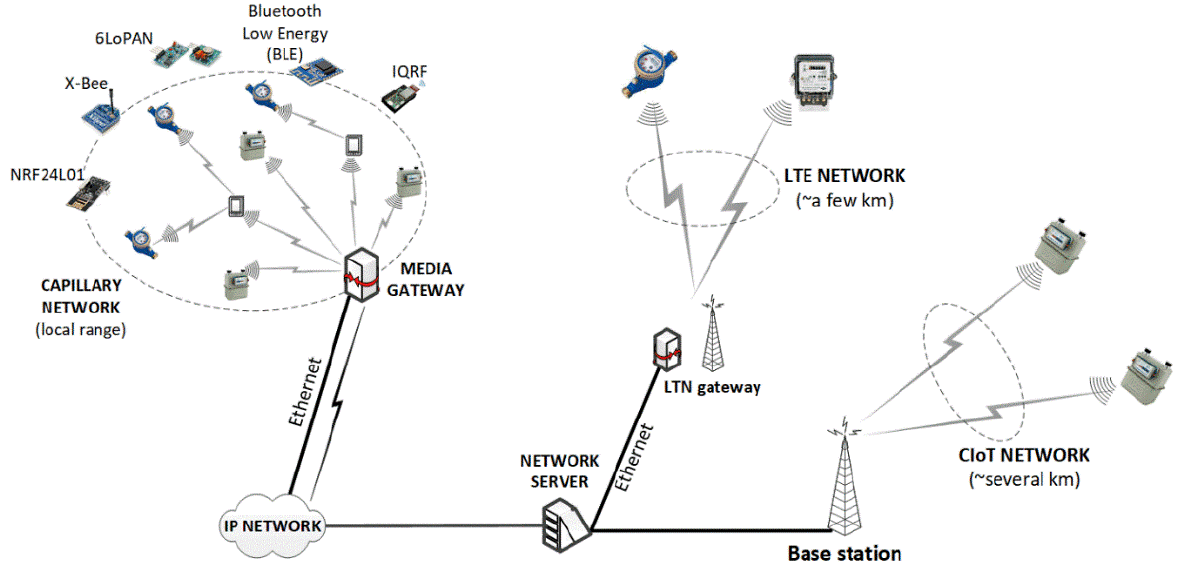
Figure 3. Illustration of the concept of capillaries and long-distance LTN/CIoT networks.